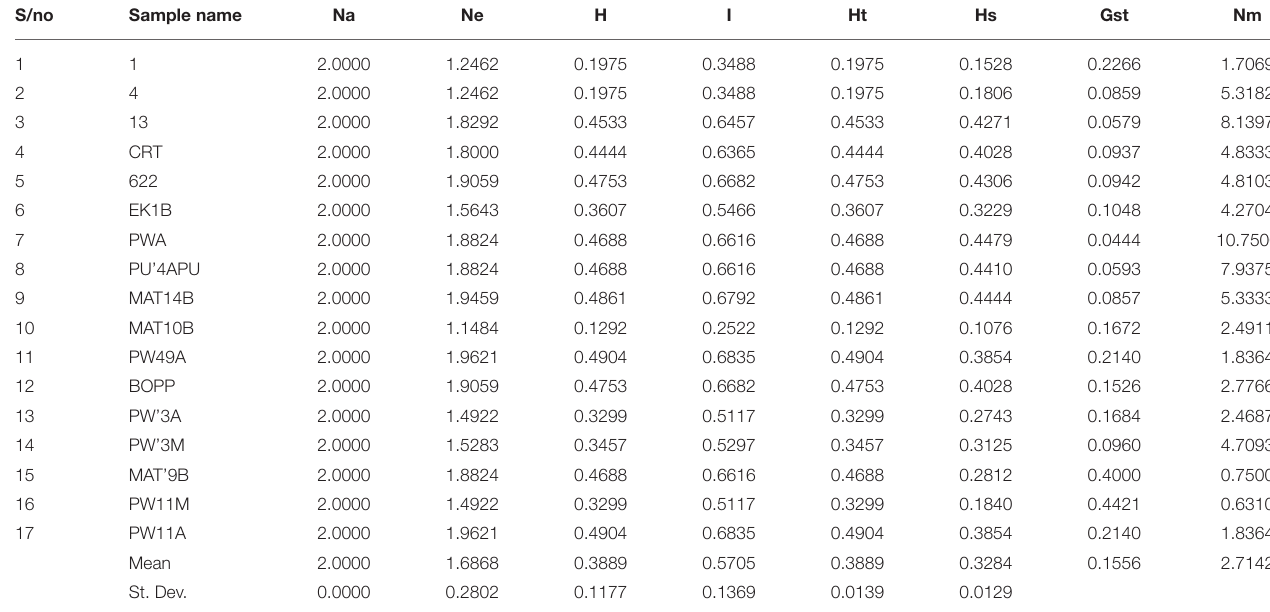
TABLE 6 | Genetic diversity and genetic differentiation parameters generated from strains of F. oxysporum f.sp. elaeidis using ISSR